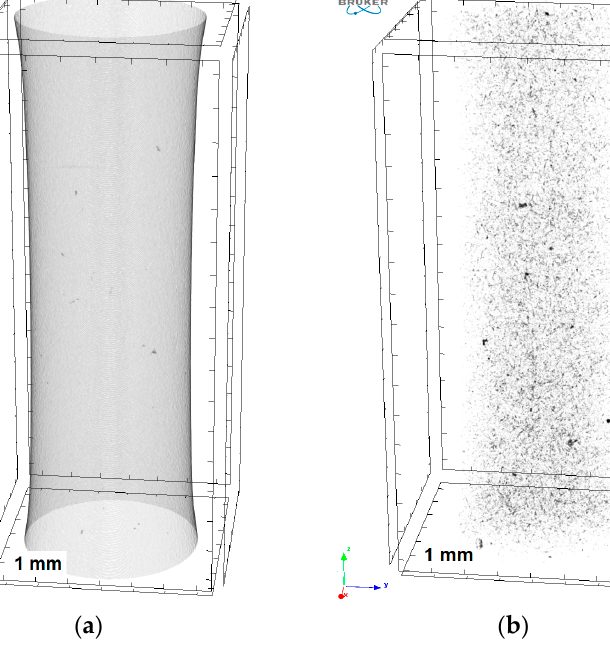
Figure 10. Gauge length of sample before loading (first R = −∞ , 2 × 10 6 cycles at − 50 MPa run out followed by tensile test) in µ-CT analysis, pores in ( a ) and network of second phases in ( b ), cross-sectional micrographs of fracture surface ( c , d ).